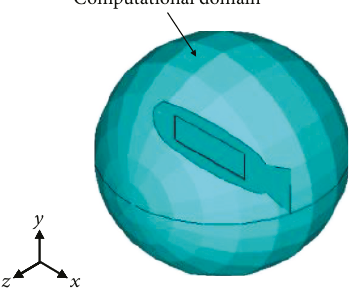
Figure 4: Structure of the soft robotic fi sh. Table 1: Material properties of soft robotic fi sh.